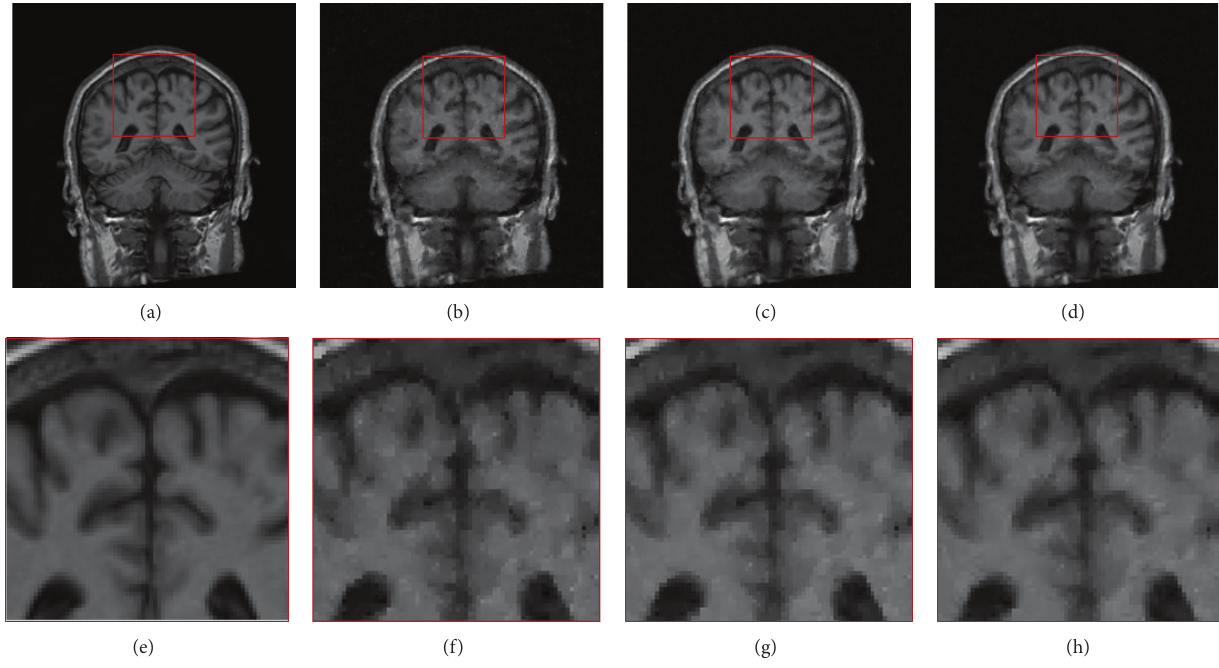
Figure 13: Original coronal brain image and experimental results with noisy data. (a) Original coronal brain image. Reconstruction at sampling rate 0.25 by (b) CS; (c) CS DT-CWT; (d) iCS technique; (e), (f), (g), and (h) are detail views of region outlined by arrow in (a), (b), (c), and (d), respectively.